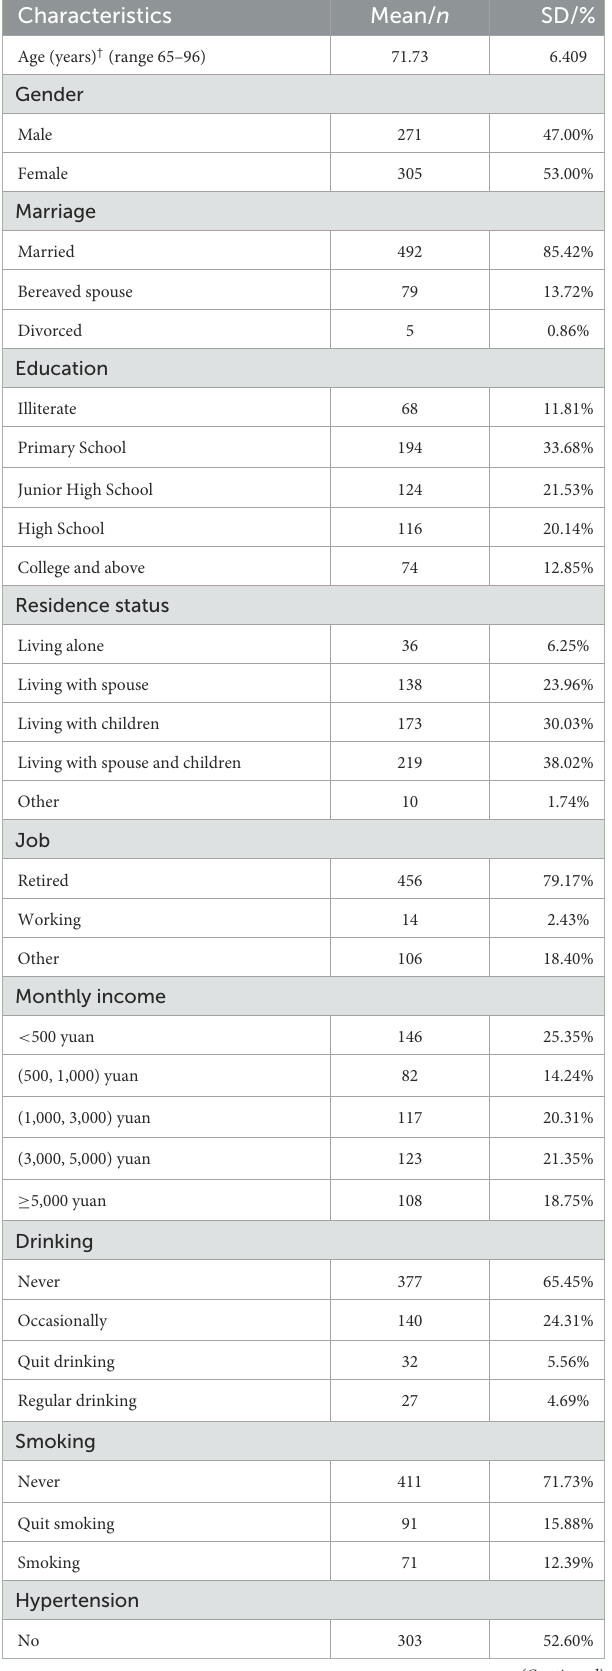
TABLE 1 Sociodemographic characteristics of the participants ( N =